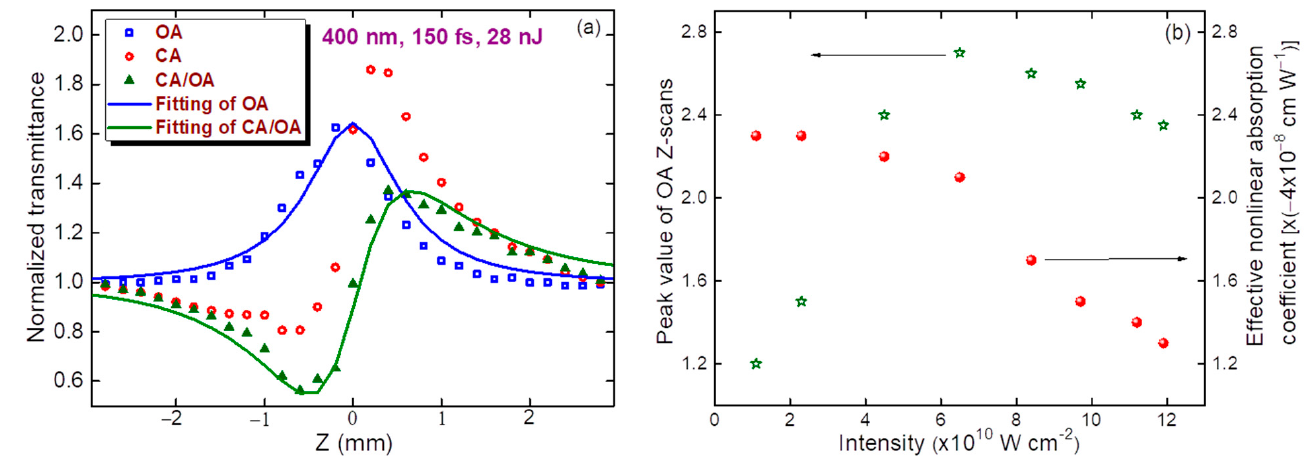
Figure 4. ( a ) Z-scans of MTQD film using 400 nm, 150 fs pulses: closed-aperture scan (CA, red empty circles), open-aperture scan (OA, blue empty squares), and CA/OA division (green filled triangles). Solid curves represent the fittings using Equations (1) (green curve) and (2) (blue curve). ( b ) Dependences of the peak value of the OA Z-scan (green stars) and effective nonlinear absorption coefficient (red diamonds) on the intensity of 400 nm, 150 fs pulses.